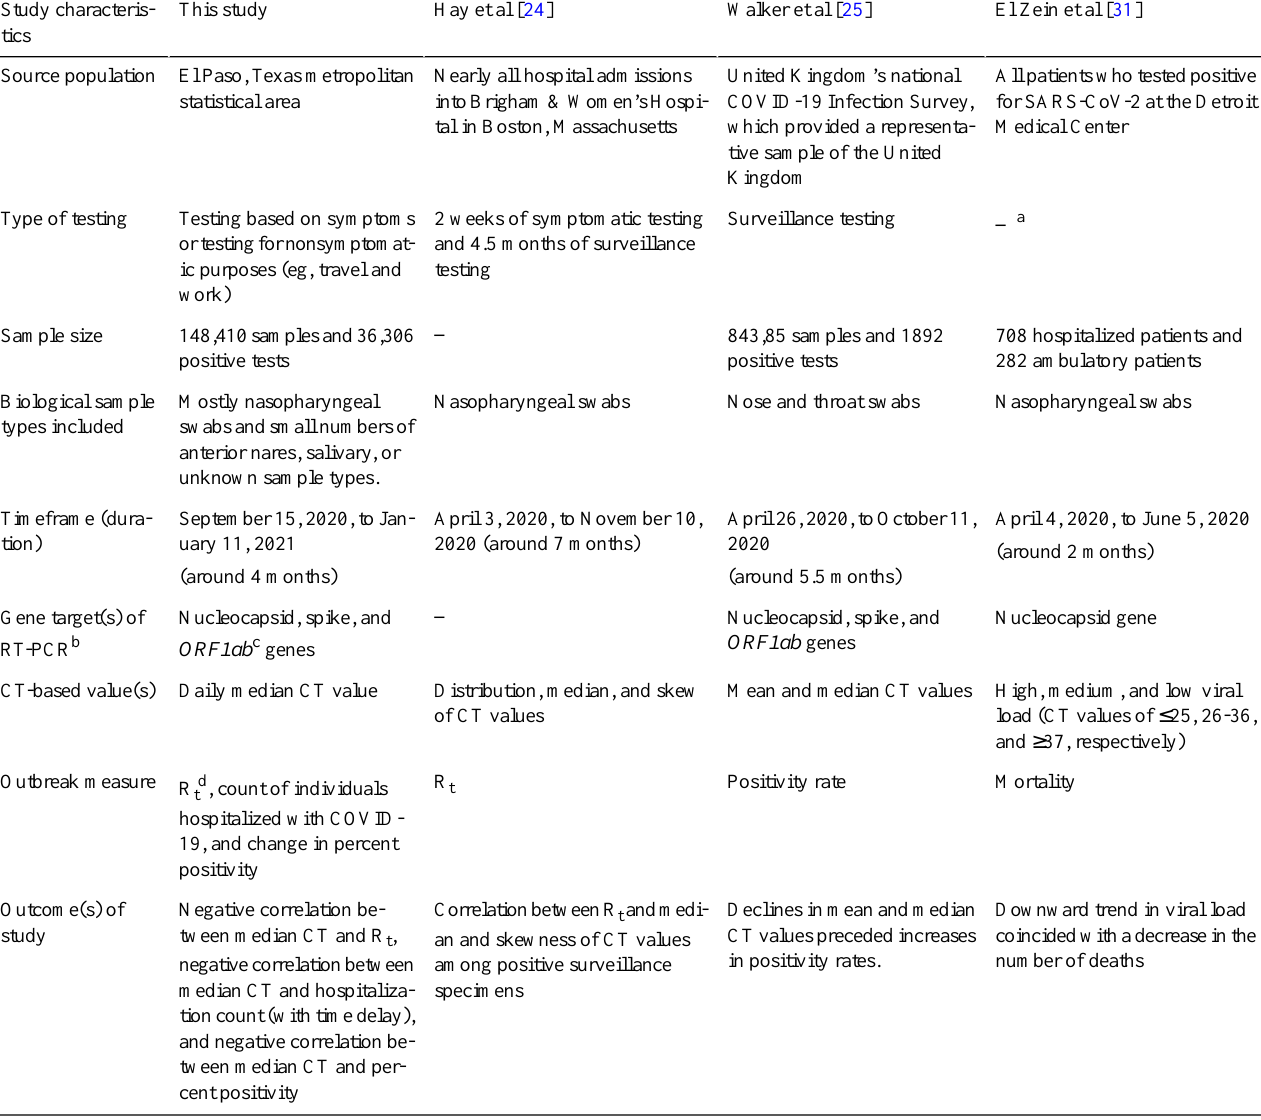
Table 3. Comparison of studies that examine cycle threshold (CT) values of SARS-CoV-2–positive samples at the population